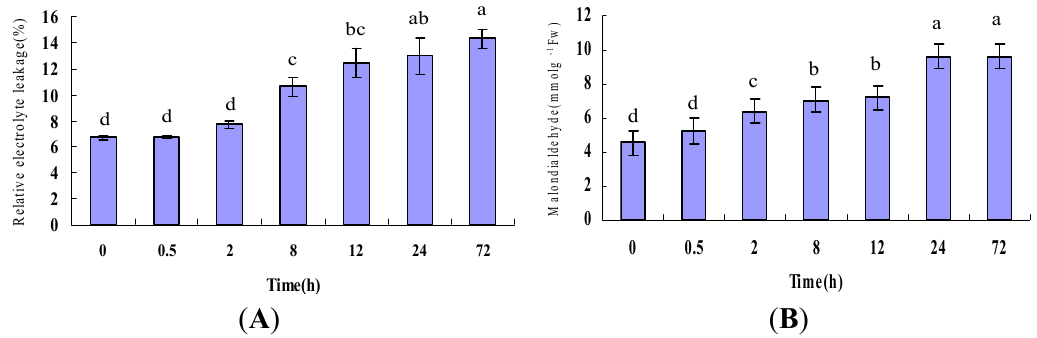
Figure 1. Physiological responses of P. ternata leaf under heat stress. ( A ) Relative electrolyte leakage; ( B ) Malondialdehyde (MDA) content of P. ternata leaves after heat treatments. Each point represents the average of three individual identical experiments (±SD). Letters above the bars (a, b, c, d, ab and bc) indicate a statistically significant difference ( p < 0.05) according to Duncan’s multiple range